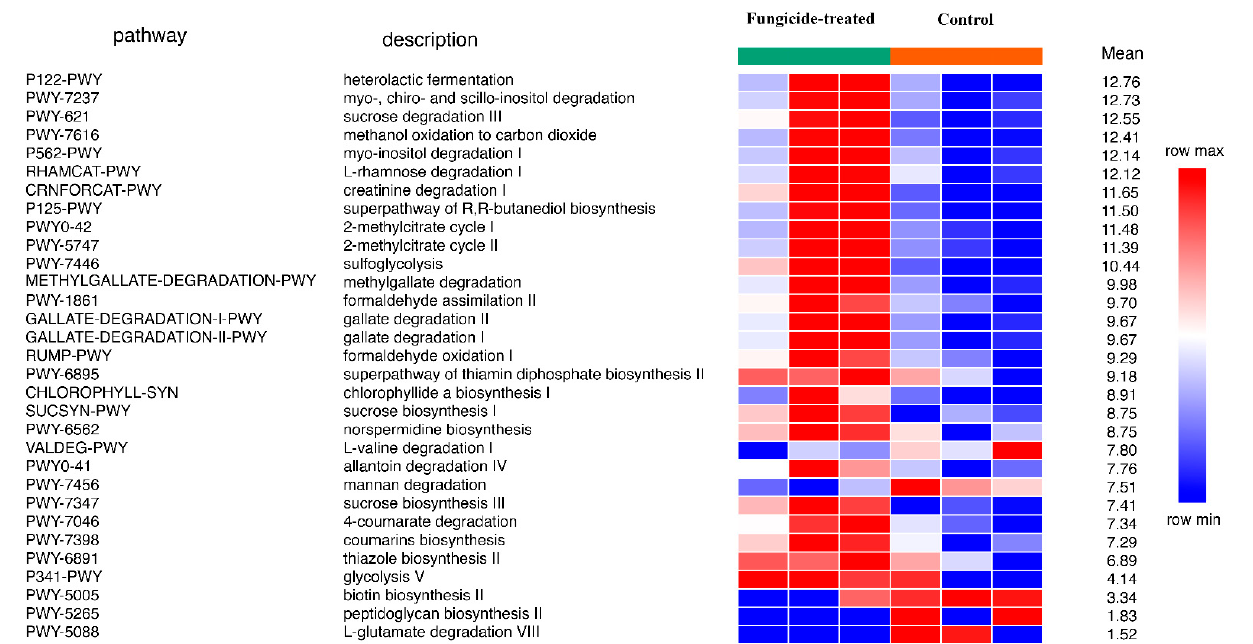
Figure 4. Differentially represented pathways of bacterial community between the control and the fungicide-treated soils. The three columns represent three replicate sequencing reactions, and each reaction was based on pooled DNA samples from three biological replicates ( p < 0.05).